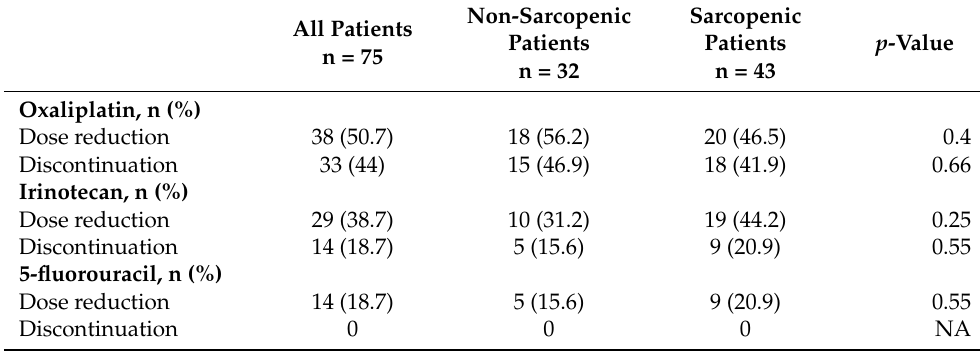
Table 3. Treatment interruption and dose reduction.